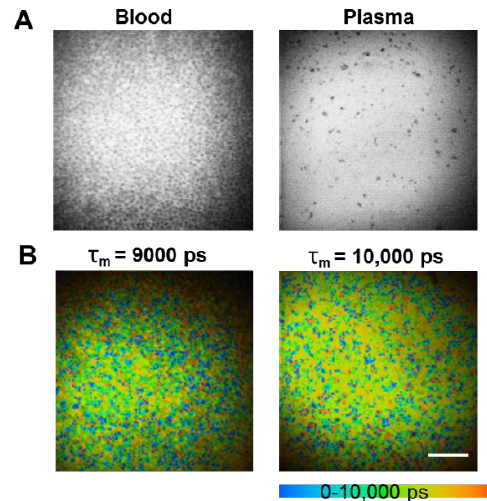
Figure 2. Fluorescence intensity image of mouse blood after QDs administration recorded at λ Exc / λ Em : 900/515 to 620 nm ( A ); Fluorescence lifetime properties of mouse blood after QDs administration measured by MPM-FLIM ( B ). Pseudocolored fluorescence lifetime image ( τ m : 0–10,000 ps; blue-green-red) recorded at λ Exc /λ Em : 900/515 to 620 nm (scale bar: 160 μm) .